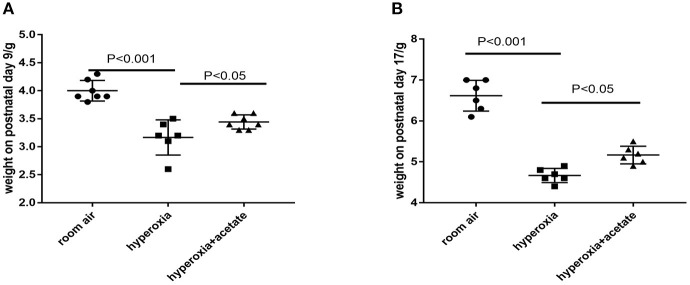
Body weight of neonatal mice. (A) Acetate-treated mice in the hyperoxia group had a significantly higher body weight on postnatal day 9 than non-acetate treated mice (P < 0.001). (B) The body weight on postnatal day 17 (P < 0.001). n = 8 mice/group. Data are expressed relative to the control group at each time point as the mean ± SEM.